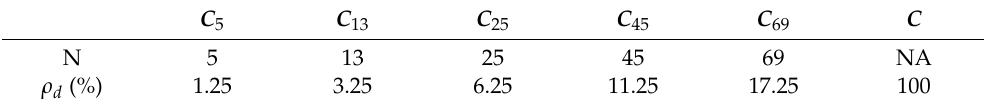
Figure 4. Demonstration of the simulated vegetation elements comprising the second experimental group design for different porosity ( ρ d ) of vegetation; smaller circles (of diameter d) represent the rod diameter used to simulate the individual element within the vegetation patch, identified with C i (where i the number of rods within the patch). Table 1. Instream vegetation characteristics with different number of rigid dowels and